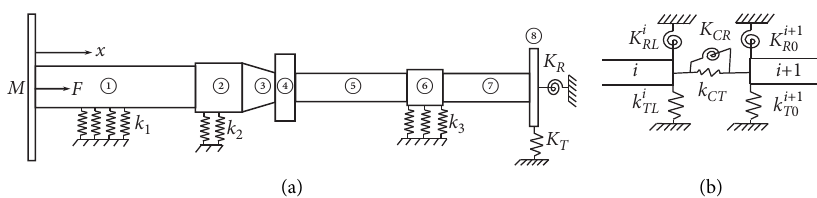
Figure 2: (a) The simplified stepped beam model of the propulsion shafting structure; (b) the coupling interface of two beam sections.